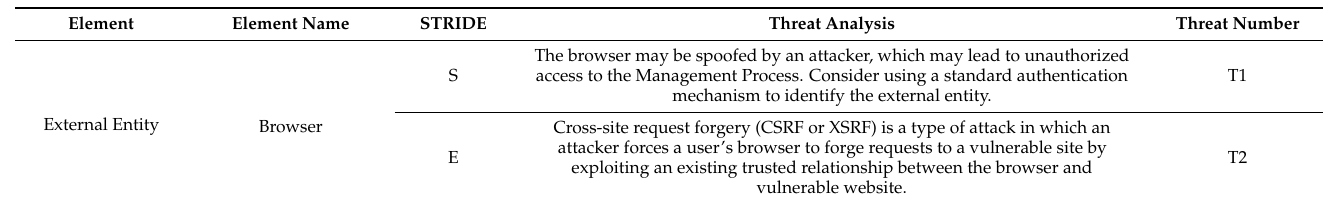
Table A1. Main threats of grid-computing-based live-streaming